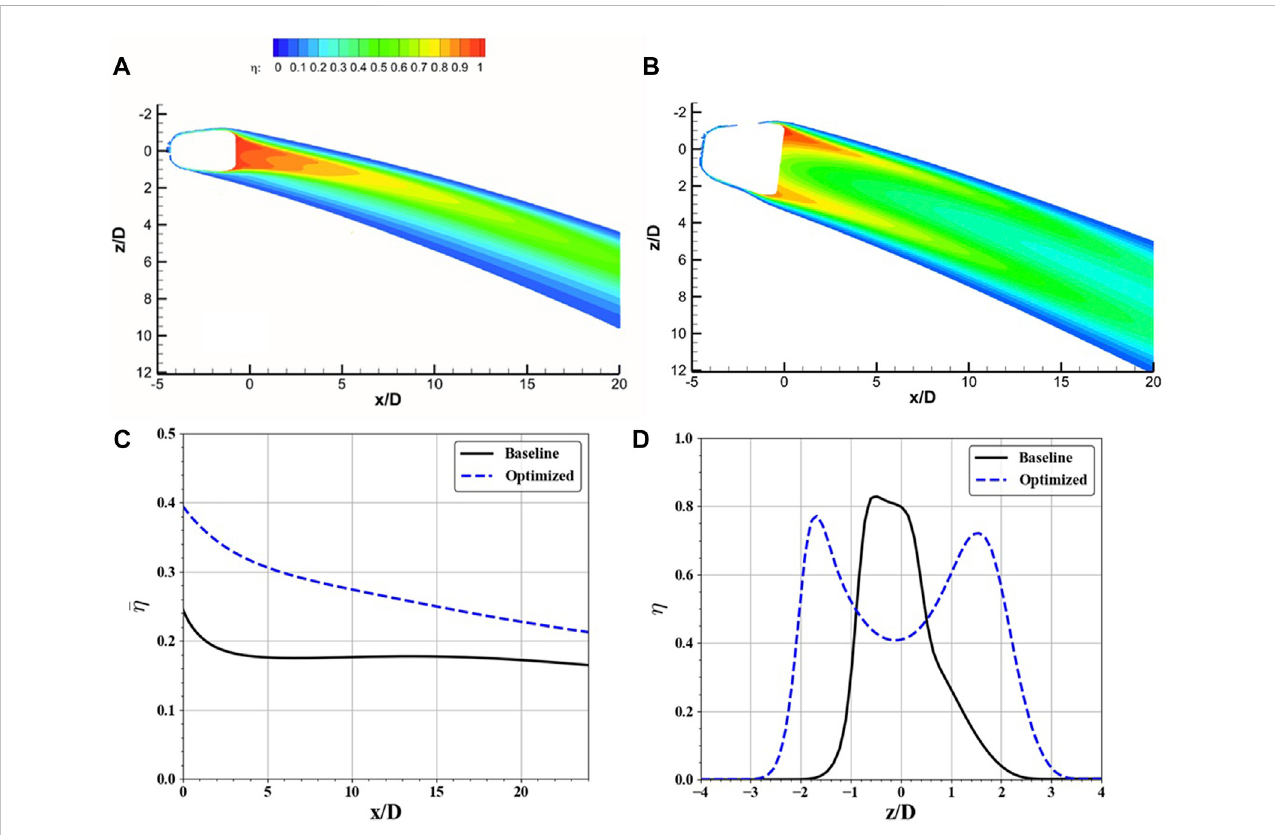
FIGURE 8 Upper row: Baseline (A) and optimized (B) adiabatic fi lm cooling effectiveness distribution contour. Lower row: Laterally averaged fi lm cooling effectiveness distribution (C) and the spanwise fi lm cooling effectiveness distribution at position x / D = 5 (D)